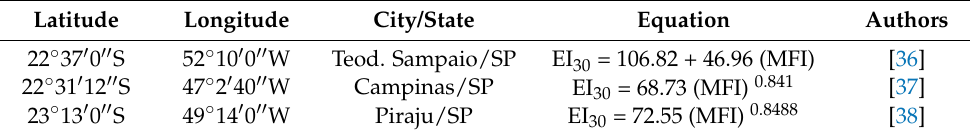
Table 2. Erosivity equations studies around the study site. Latitude Longitude City/State